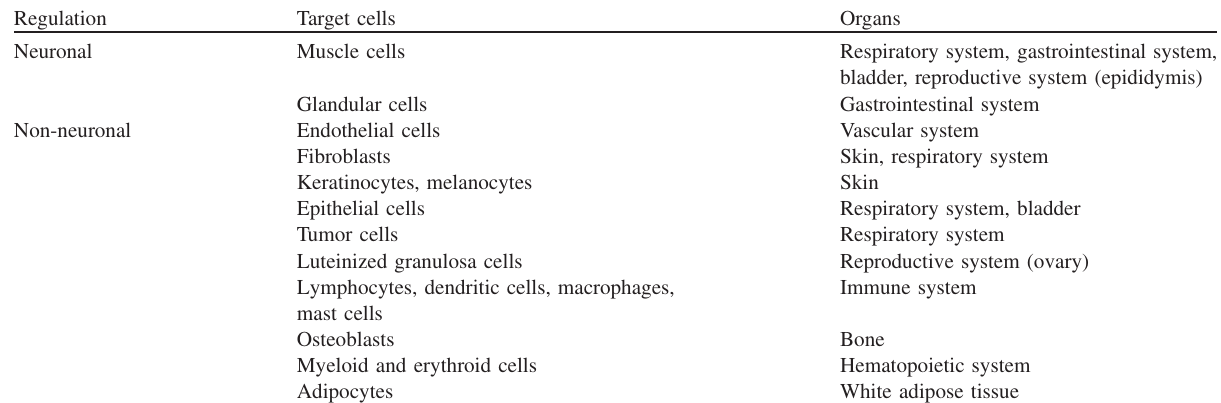
Table 1 Target cells, organs, and